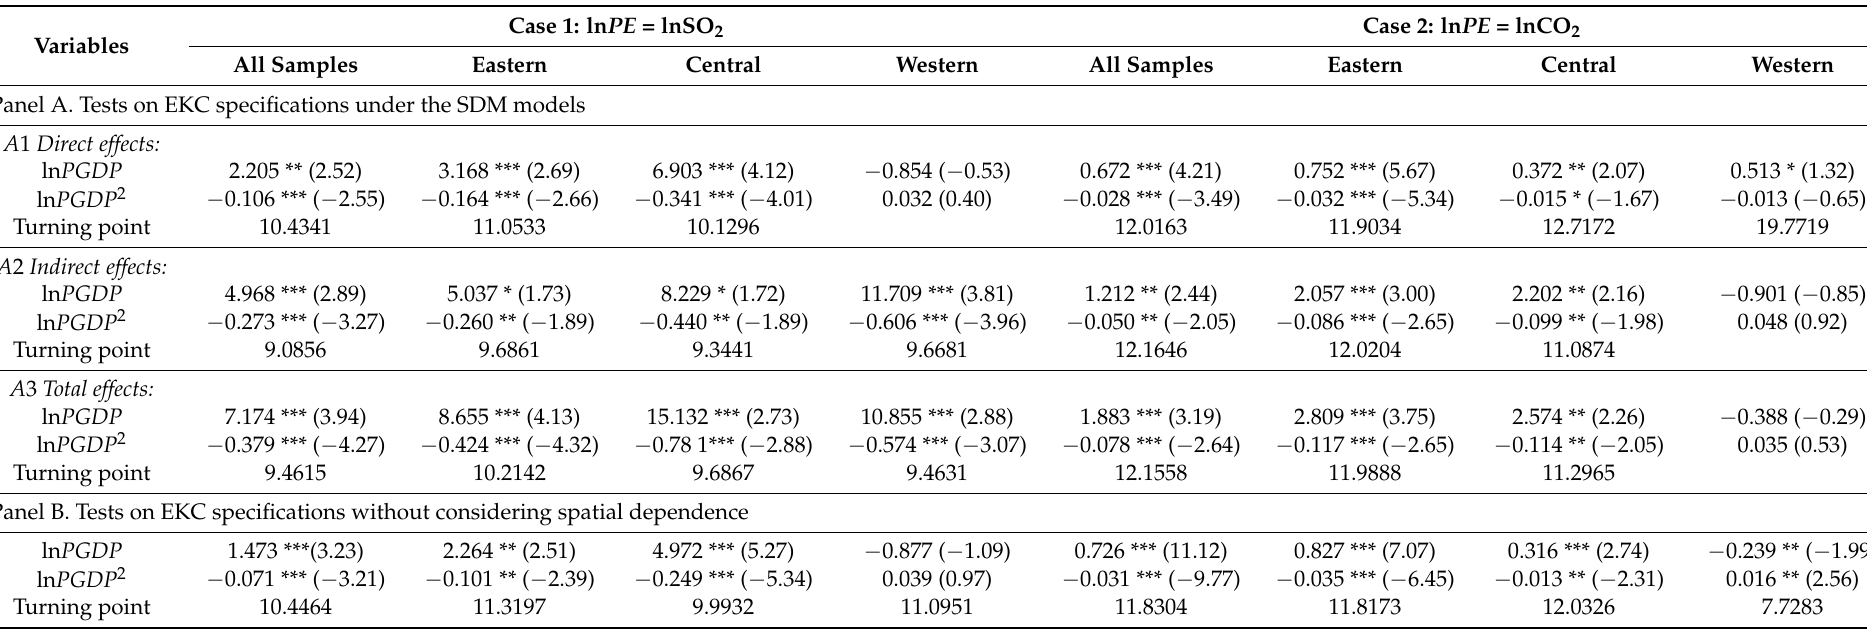
Table 7. Direct, indirect, and total marginal effects of SDMs and their EKC turning points, compared with those without identifying spatial